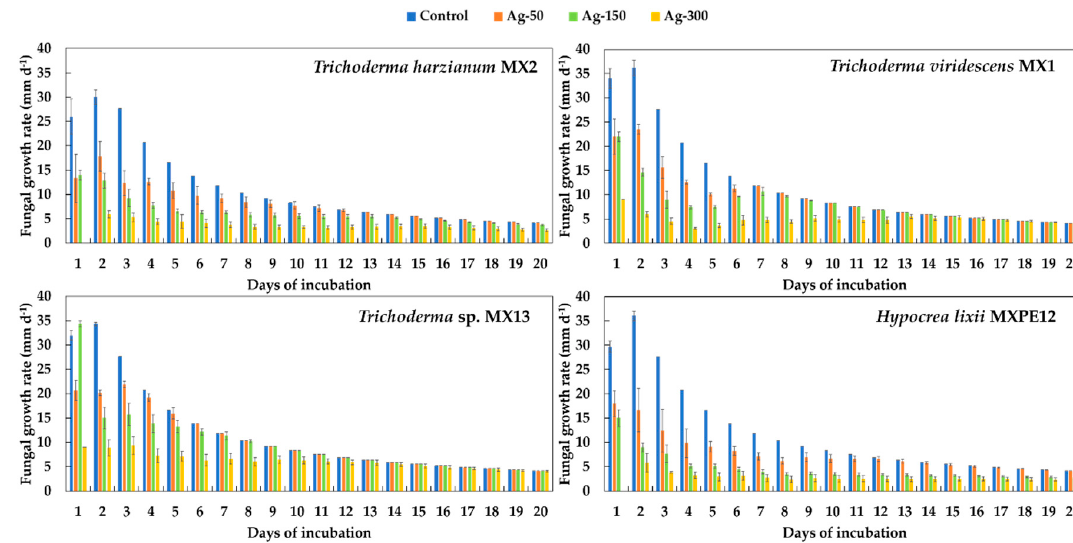
Figure 4. Fungal growth rate of four filamentous fungi strains exposed to four doses of silver (mg L − 1 ). T. viridescens MX1 and T. sp. MX13 were more tolerant than other strains (n = 3, means ± standard error).